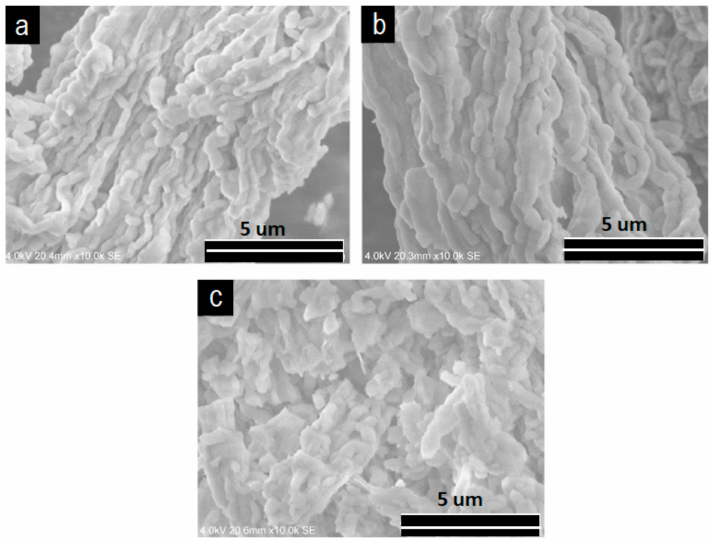
Figure 3. SEM images of V 2 O 5 /SBA-15. ( A ) 10V/SBA-15; ( B ) 20V/SBA-15; ( C )